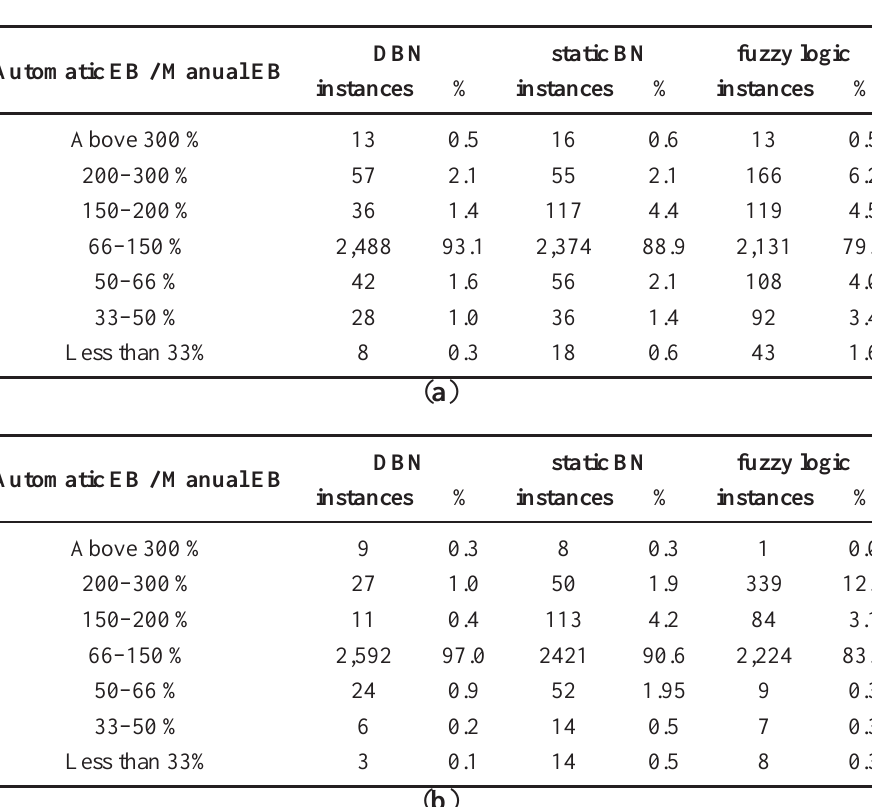
Table 3. A comparison of uncertainty measures of the DBN (section 6), static BN [15] and fuzzy logic assessment systems [14] expressed as a histogram of the ratio of automatic quality metrics and manual error bars across a test-set of 2,672 samples for the temperature sensors in Sullivans Cove. ( a ) Temperature sensor situated at a depth of 1 m; ( b ) Temperature sensor situated at a depth of 10 m.